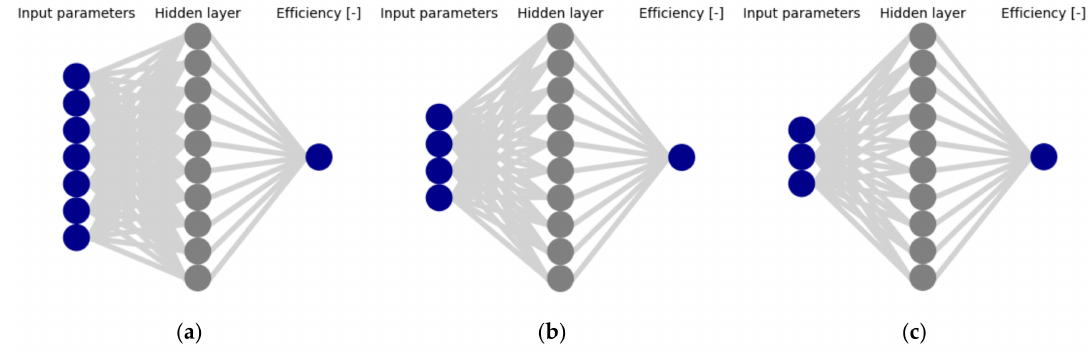
Figure 8. Architecture of the neural network: ( a ) 7 input parameters; ( b ) 4 input parameters; ( c ) 3 in- put